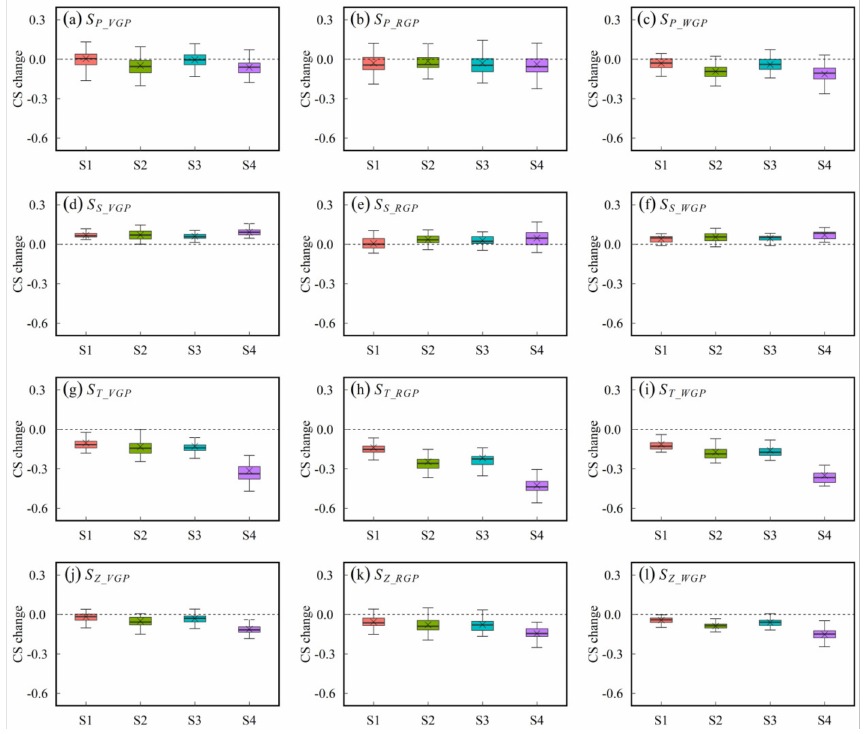
Figure 3. Changes in projected maize climate suitability for the vegetative growth period ( a , d , g , j ), reproductive growth period ( b , e , h , k ) and whole growth period ( c , f , i , l ) during the 2040s and 2080s compared to 1981–2010 (S1, S2, S3, and S4 are the SSP245_2040s, SSP245_2080s, SSP585_2040s, and